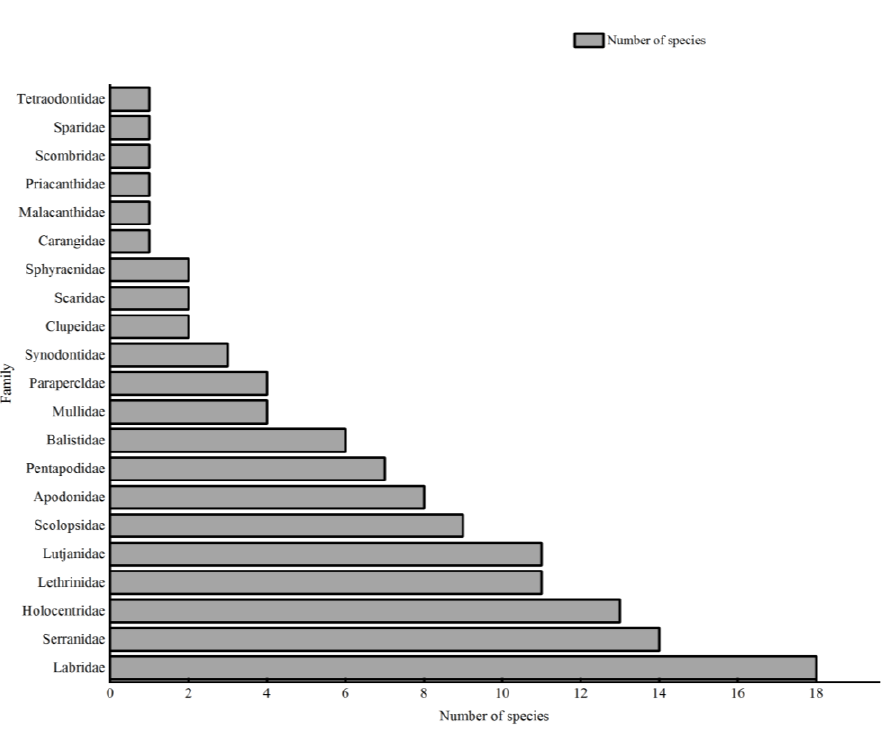
Figure 2. The total species number by family in the four coral